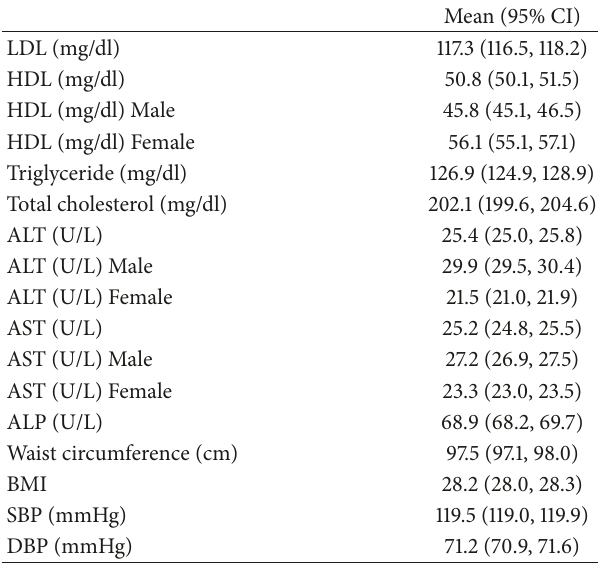
Table 2: Mean values of lipid biomarkers and liver enzymes among